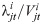
Optimal social distancing policy (left-hand panel) and social cost relative to private cost of infection, λjti/Vjti (right-hand panel) as a function of current infected for the four different groups.Parameter values as specified in the main text.